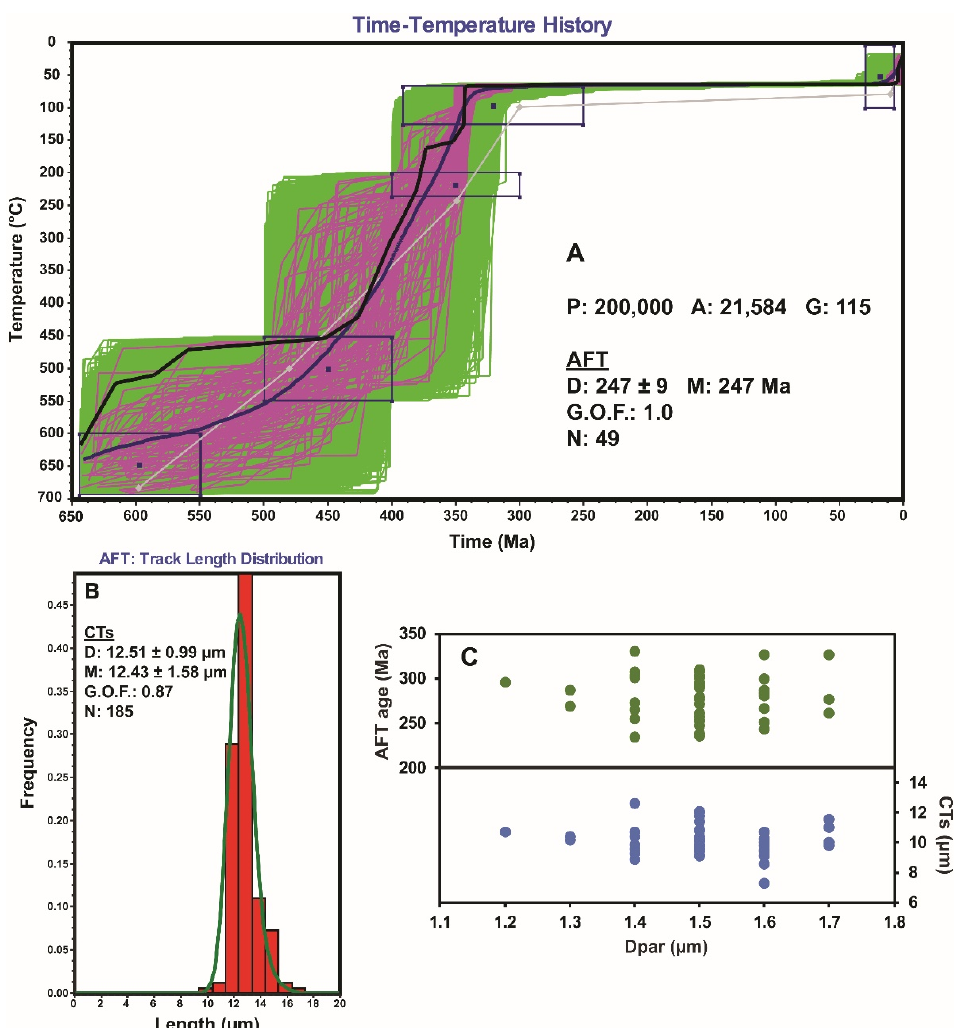
Figure 8. ( A ): Thermal history model for the studied sample obtained using HeFTy [103]. Resulting t–T curves show four different reliability levels; green paths: acceptable fit (all t–T paths with a merit function value of at least 0.05), purple paths: good fit (all t–T paths with a merit function value of at least 0.5), black line: best fit and dashed blue line: the weighted mean path [101,108]. Four constrain boxes, based on zircon U-Pb, apatite U-Pb, ZFT, and AFT ages, and the Gulf of Suez initiation age were chosen to guide the randomness. P: number if inverse models’ iterations, A: acceptable fit models, G: good fit models, D: determined FT age ± 1- σ error, M: modelled FT age, G.O.F.: goodness of fit between the measured and the model age, N: number of single grains. ( B ): Confined track lengths (CTs) distribution for the c-axis projected tracks. D: determined CTs ± 1- σ error, M: modelled CTs ± 1- σ error, G.O.F.: goodness of fit between the measured and the model CTs, N: number of CTs. ( C ): comparison between the corresponding AFT details of AFT age, CTs lengths, and Dpar values.